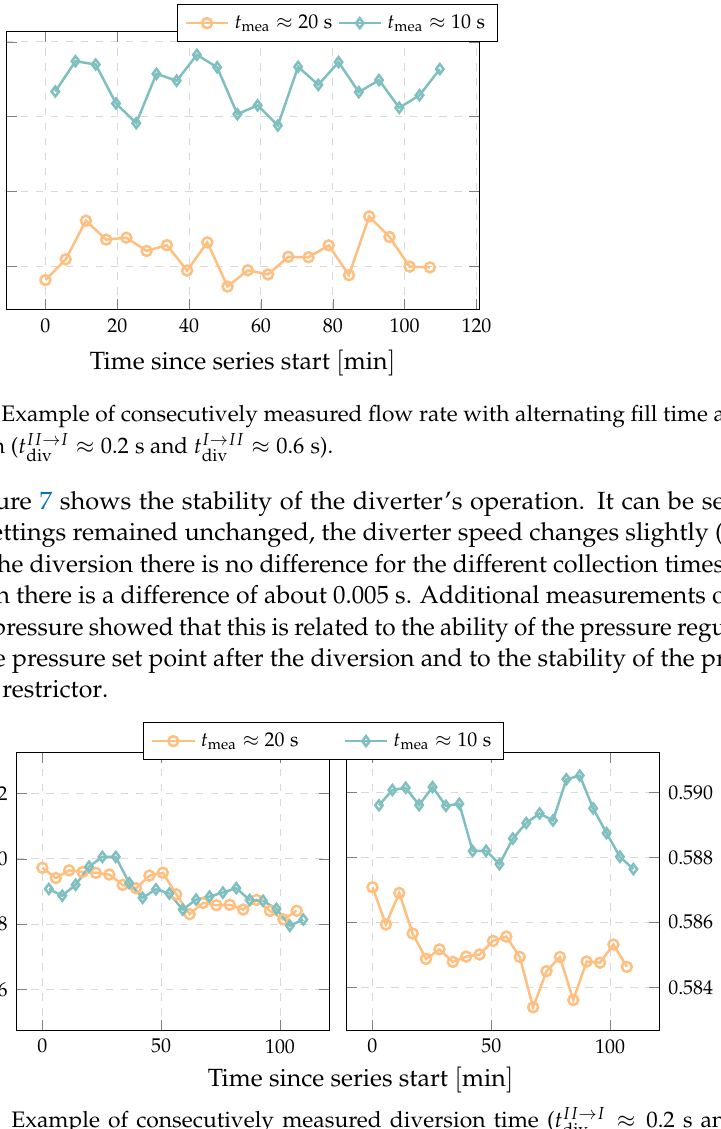
Figure 7. Example of consecutively measured diversion time ( t II → I q m ≈ 9 mgmin − 1